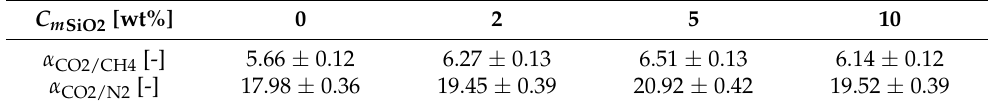
Table 7. Coefficients of ideal selectivity α i/j for membranes of different SiO 2 concentrations.